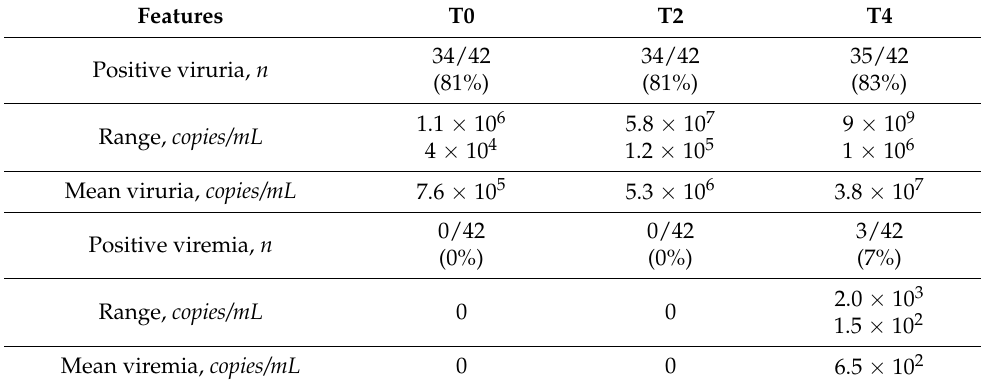
Table 2. Viruria and viremia in ocrelizumab treated MS